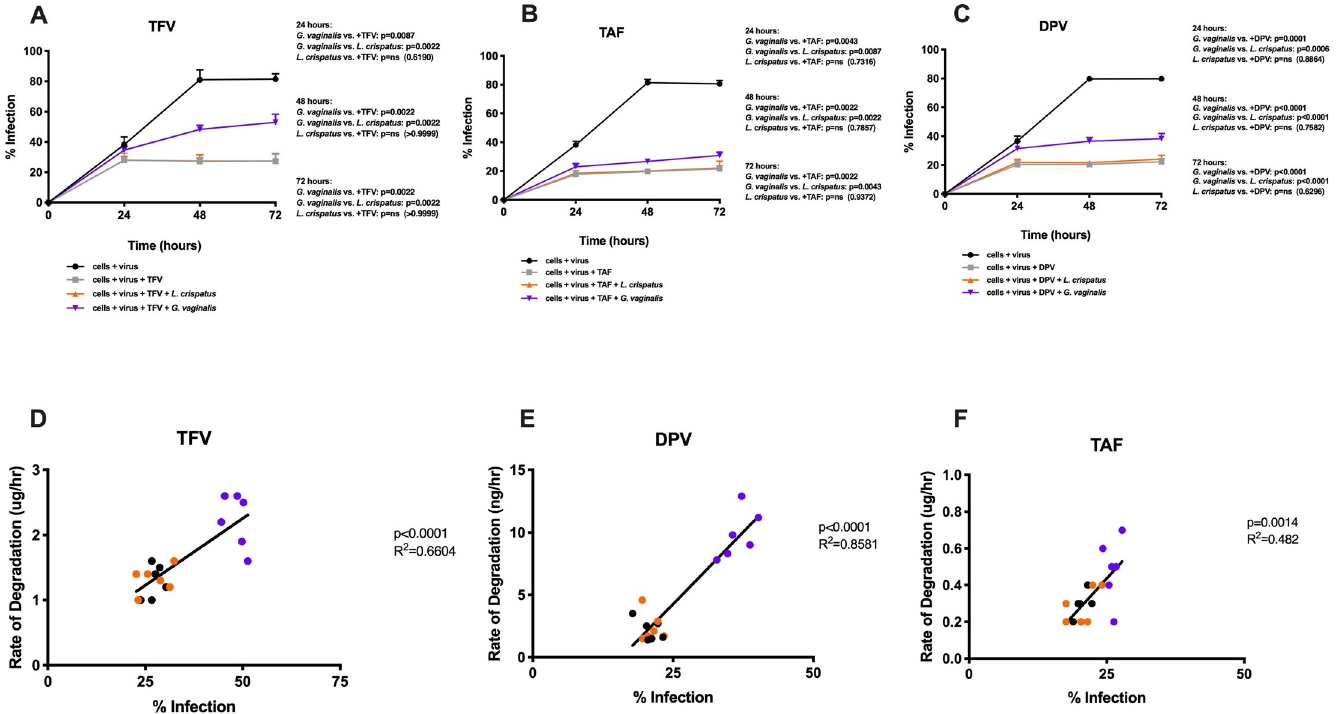
Fig 7. HIV-1 LAI infection of CEM-GFP cells after incubation at 37C. (A). % Infection of CEM-GFP cells over time up to 72 hours post-incubation with 1) CEM-GFP cells + HIV-1 LAI 2) CEM-GFP cells + HIV-1 LAI + TFV 3) CEM-GFP cells + HIV-1 LAI + TFV + L . crispatus 4) CEM-GFP cells + HIV-1 LAI + TFV + G . vaginalis . CEM-GFP cells were incubated for 30 minutes with bacterial inoculum. TFV was added and allowed to incubate for 1.5 hours prior to HIV-1 LAI addition. Purple G . vaginalis ; Orange, L . crispatus; Black, virus alone; Gray, virus and TFV. N = 6. (B) % Infection of CEM-GFP cells over time up to 72 hours post-incubation with 1) CEM-GFP cells + HIV-1 LAI 2) CEM-GFP cells + HIV-1 LAI + TAF 3) CEM-GFP cells + HIV-1 LAI + TAF + L . crispatus 4) CEM-GFP cells + HIV-1 LAI + TAF + G . vaginalis . CEM-GFP cells were incubated for 30 minutes with bacterial inoculum. TAF was added and allowed to incubate for 1.5 hours prior to HIV-1 LAI addition. Purple G . vaginalis ; Orange, L . crispatus; Black, virus alone; Gray, virus and TAF. N = 6. (C) % Infection of CEM-GFP cells over time up to 72 hours post-incubation with 1) CEM-GFP cells + HIV-1 LAI 2) CEM-GFP cells + HIV-1 LAI + DPV 3) CEM-GFP cells + HIV-1 LAI + DPV + L . crispatus 4) CEM-GFP cells + HIV-1 LAI + DPV + G . vaginalis . CEM-GFP cells were incubated for 30 minutes with bacterial inoculum. DPV was added and allowed to incubate for 1.5 hours prior to HIV-1 LAI addition. Purple G . vaginalis ; Orange, L . crispatus; Black, virus alone; Gray, virus and DPV. N = 6. (D) Rate of TFV degradation versus % infection of CEM-GFP cells 48 hours after incubation with virus. Purple G . vaginalis ; Orange, L . crispatus; Black, TFV alone. N = 6. (E) Rate of TAF degradation versus % infection of CEM-GFP cells 48 hours after incubation with virus. Purple G . vaginalis ; Orange, L . crispatus; Black, TAF alone. N = 6. (F) Rate of DPV degradation versus % infection of CEM-GFP cells 48 hours after incubation with virus. Purple G . vaginalis ; Orange, L . crispatus; Black, DPV alone. N = 6.